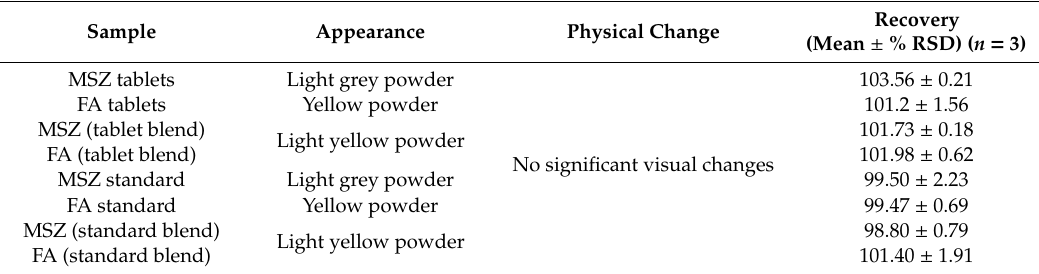
Table 4. Isothermal stress testing results (after 4